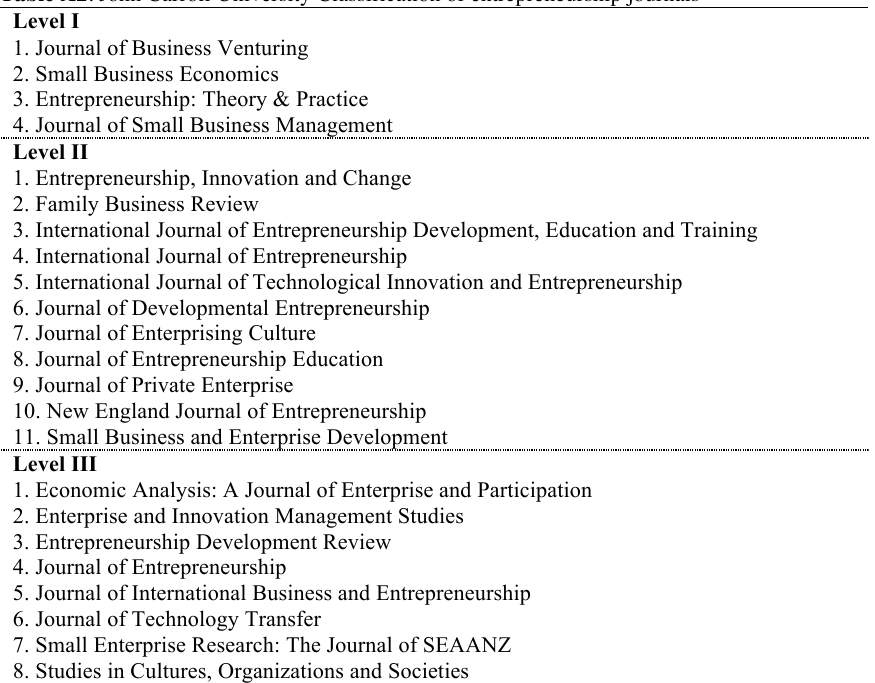
Table A2 . John Carroll University Classification of entrepreneurship journals Level